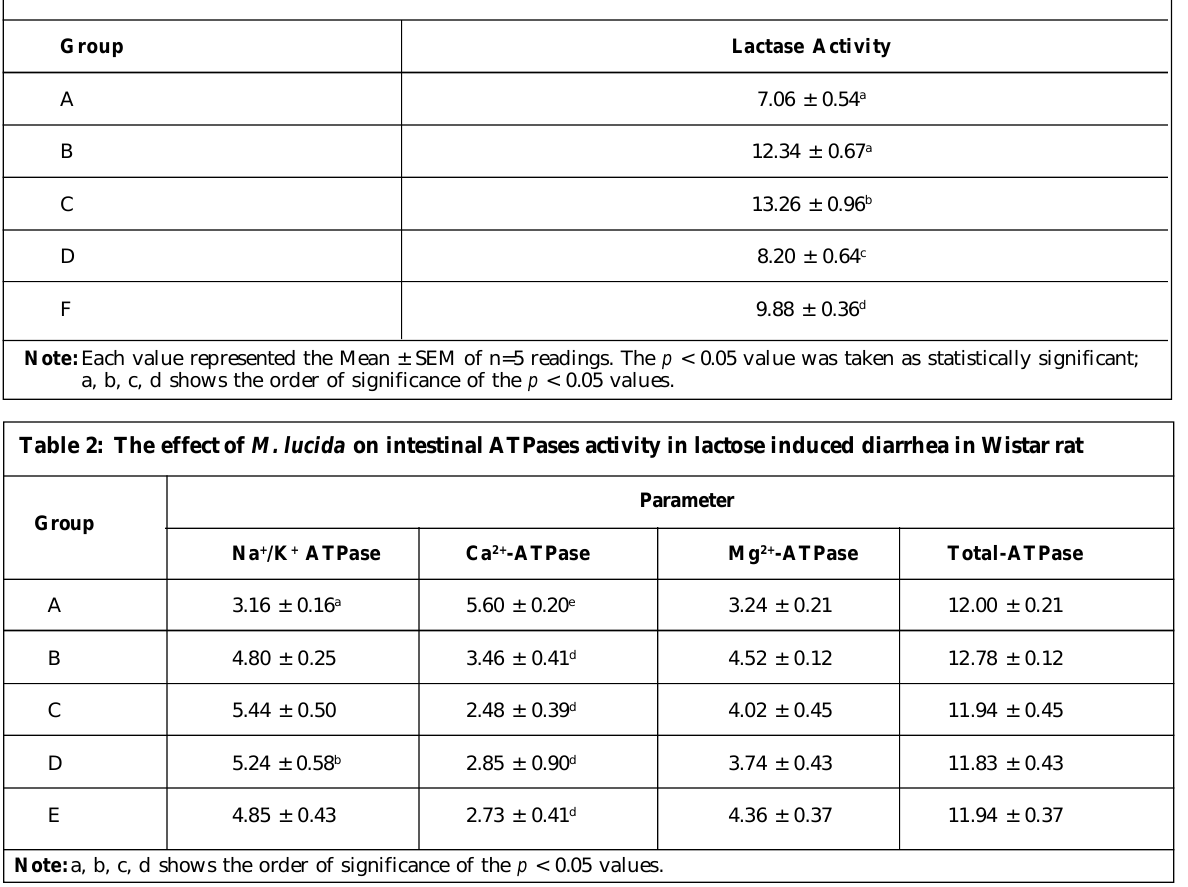
Table 1: The effect of M. lucida on intestinal lactase activity in lactose induced diarrheic Wistar